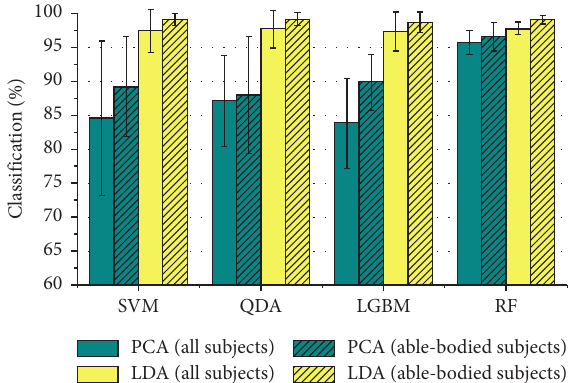
Figure 4: Steady-state accuracy with different dimension reduction methods and classifiers in different subject groups. Error bars represent ±